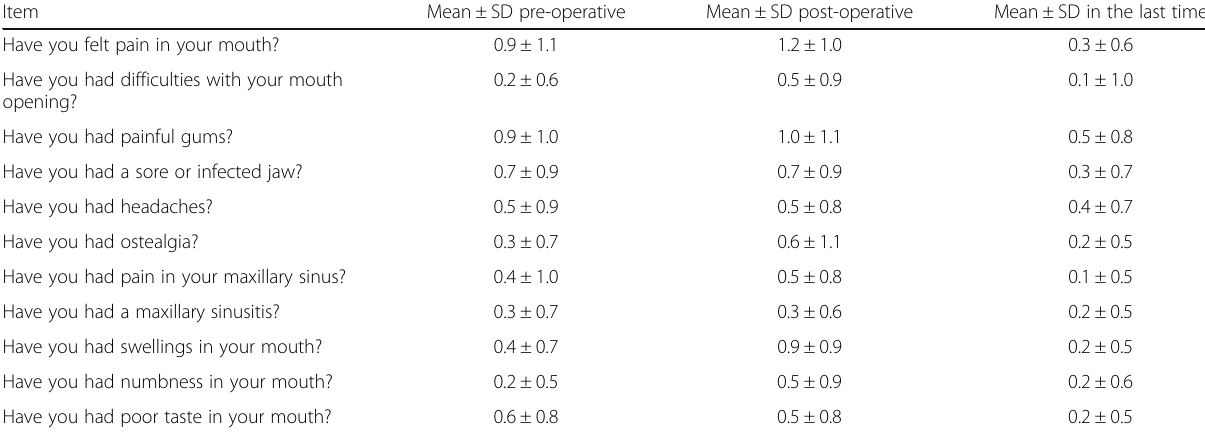
Table 3 Mean value and standard deviation for the subcategory complaints due to the surgical procedure Item